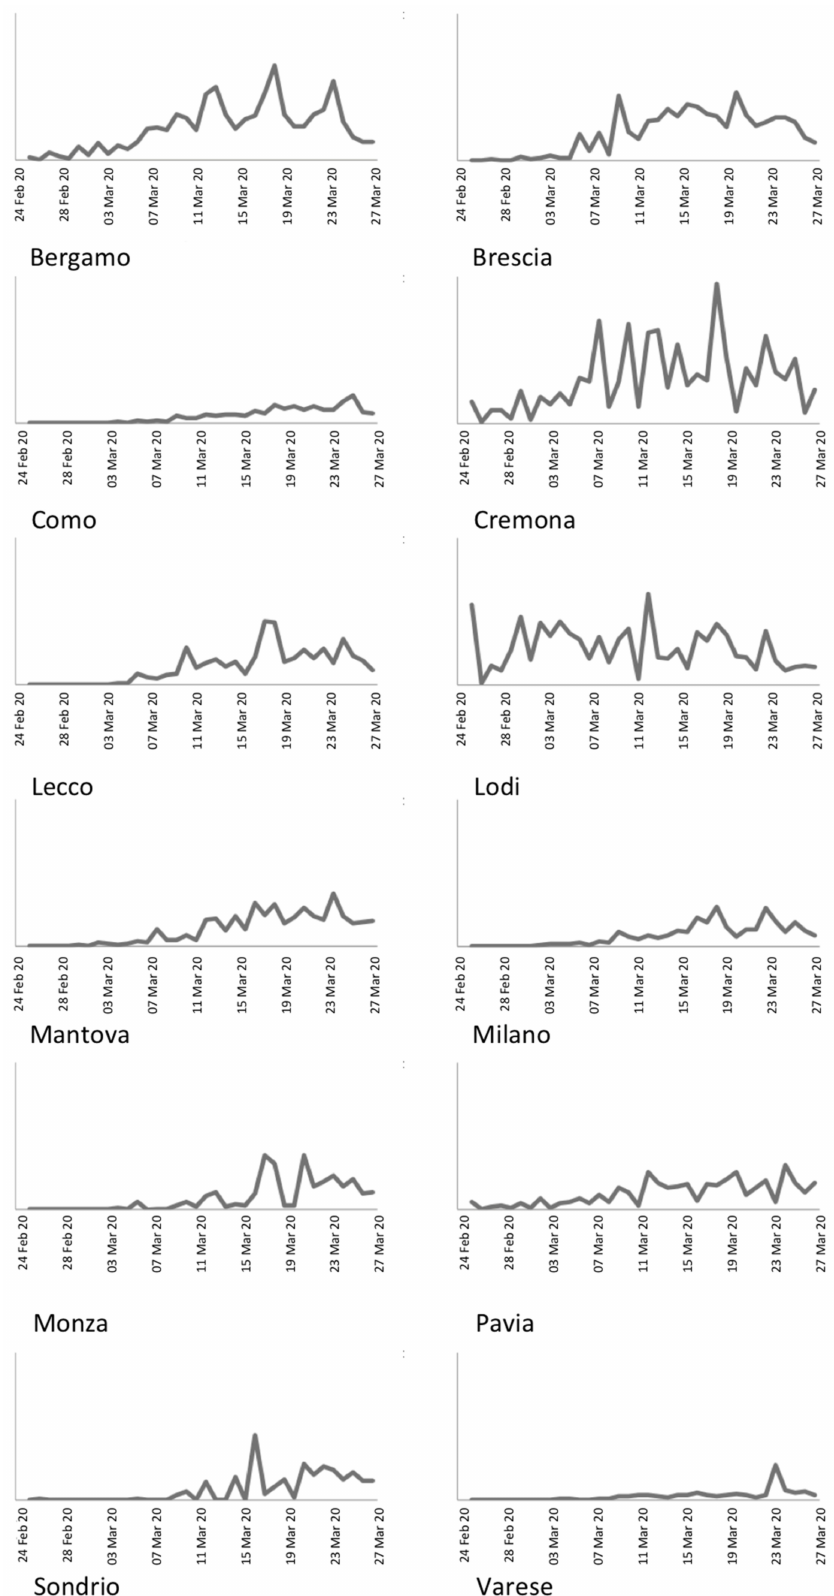
Figure 4. Daily incidence rate for the Lombardy